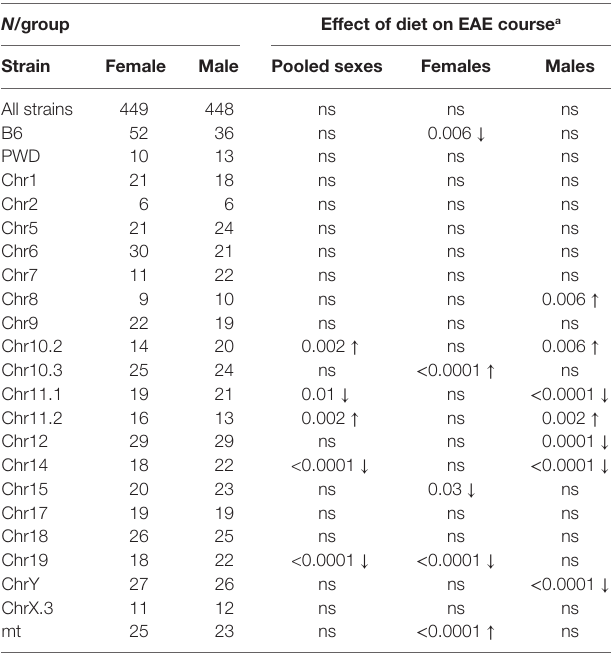
TaBle 1 | Effects of vitamin D3 (VitD) on EAE disease course in B6.Chr PWD consomic